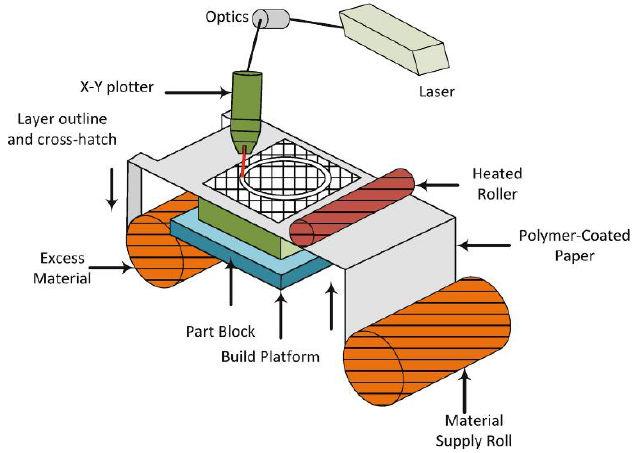
Figure 6. Schematic of sheet lamination process [25]; with permission from Springer Nature.